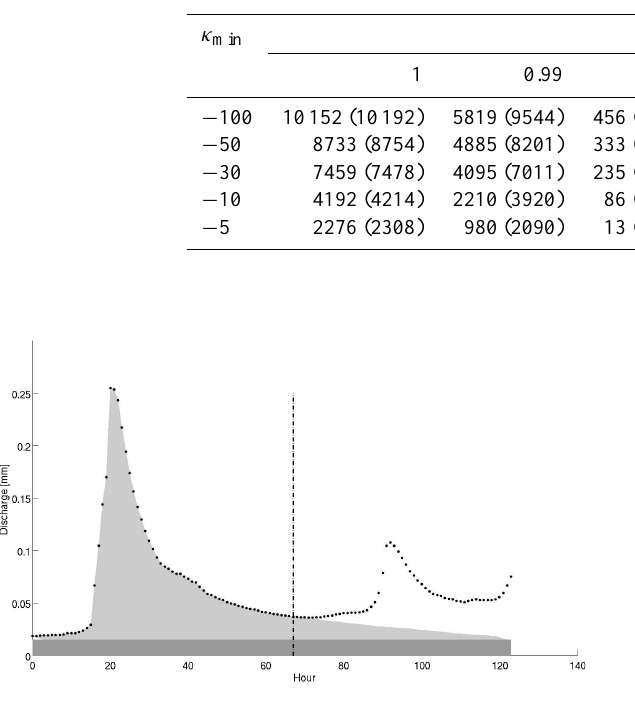
Fig. 3. Schematic showing the calculation of the runoff volume as- sociated with an event. The lighter shaded area represents the runoff volume associated with the event which starts at time 0 and the darker shaded area an underlying baseflow The subsequent events starts after 67h (solid line) so the lighter shaded area after this time is extrapolated using the MRC.